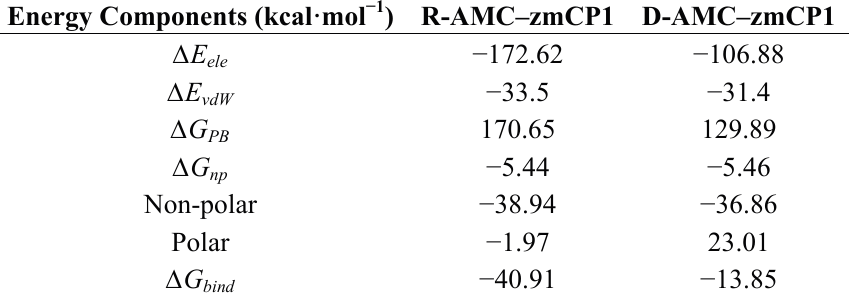
Table 5. The MM-PBSA score for R-AMC–zmCP1 complex and D-AMC–zmCP1